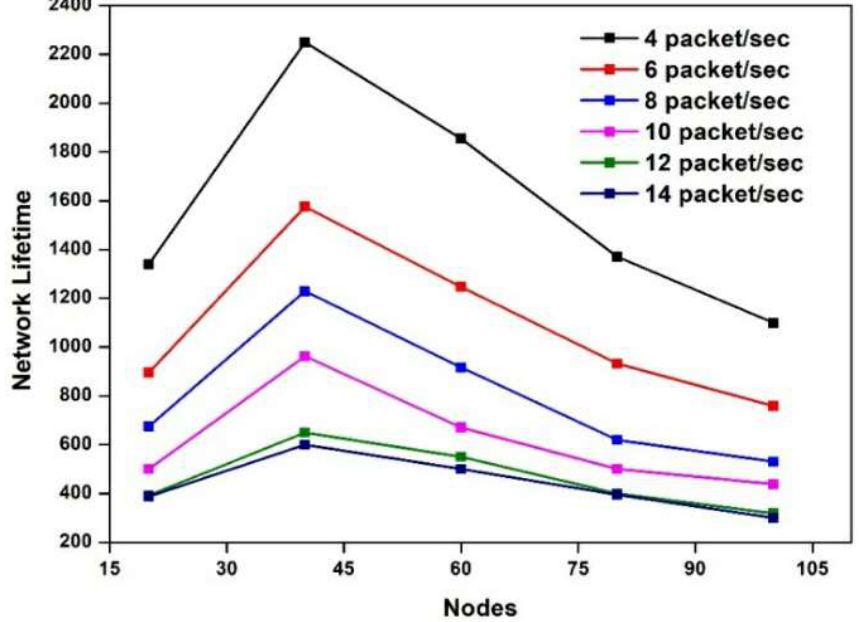
Figure 11. Network lifetime.